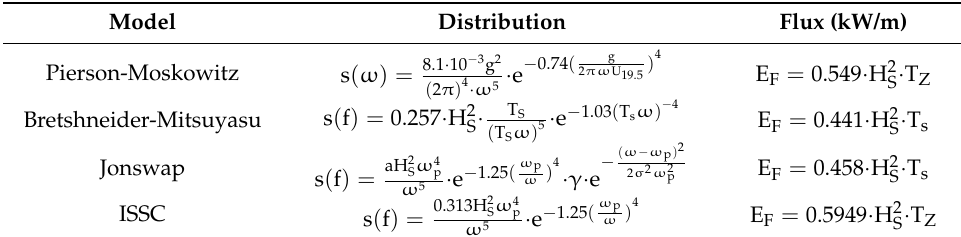
Table 6. Summary of wave energy equations depending on the model selected [21].